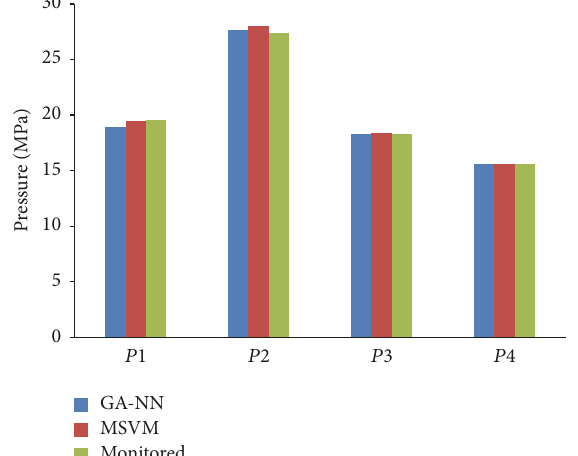
Figure 6: Comparison of borehole pressures obtained by different prediction methods and monitored data.